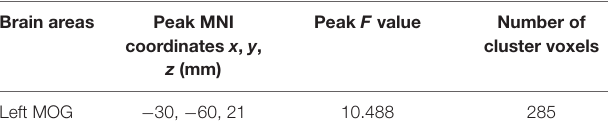
TABLE 2 | Brain region that displayed a different cerebrovascular reactivity among the three